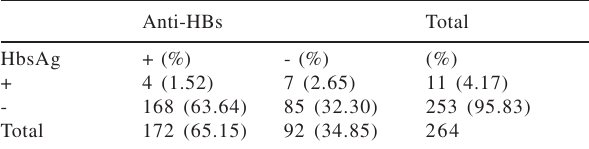
Table 3 - Correlation between HBsAg and Anti-HBs.